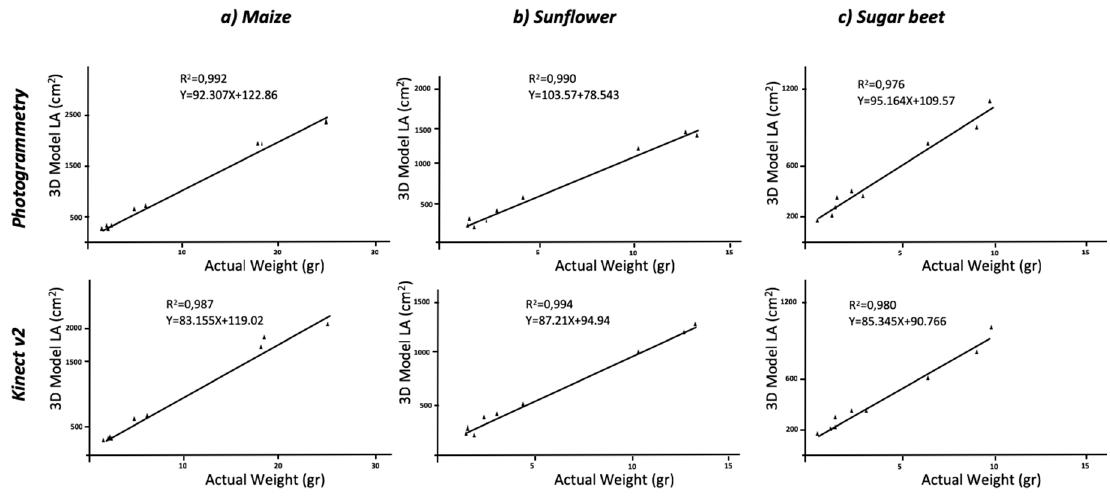
Figure 5. Regression analyses comparing actual leaf area versus measured dry biomass using 3D modeling methods.